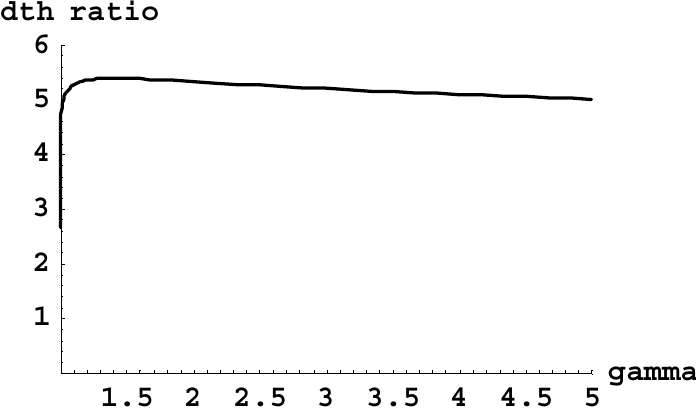
Figure 13. Ratio Γ σ / Γ π of the widths of the σ - and π -components of the Ly-alpha line versus the relativistic factor γ at N e = 10 15 cm − 3 and T e = 2 eV [82].